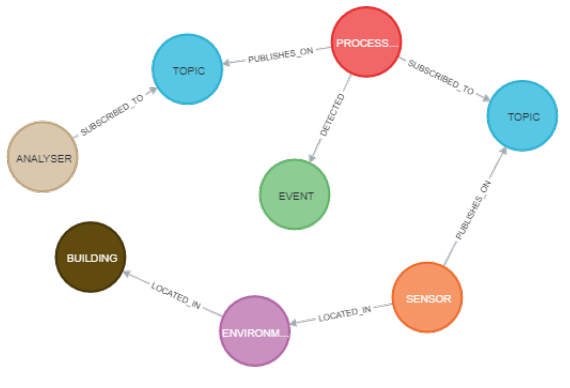
Figure 10. Representation, in Neo4j, of the involved actors together with their